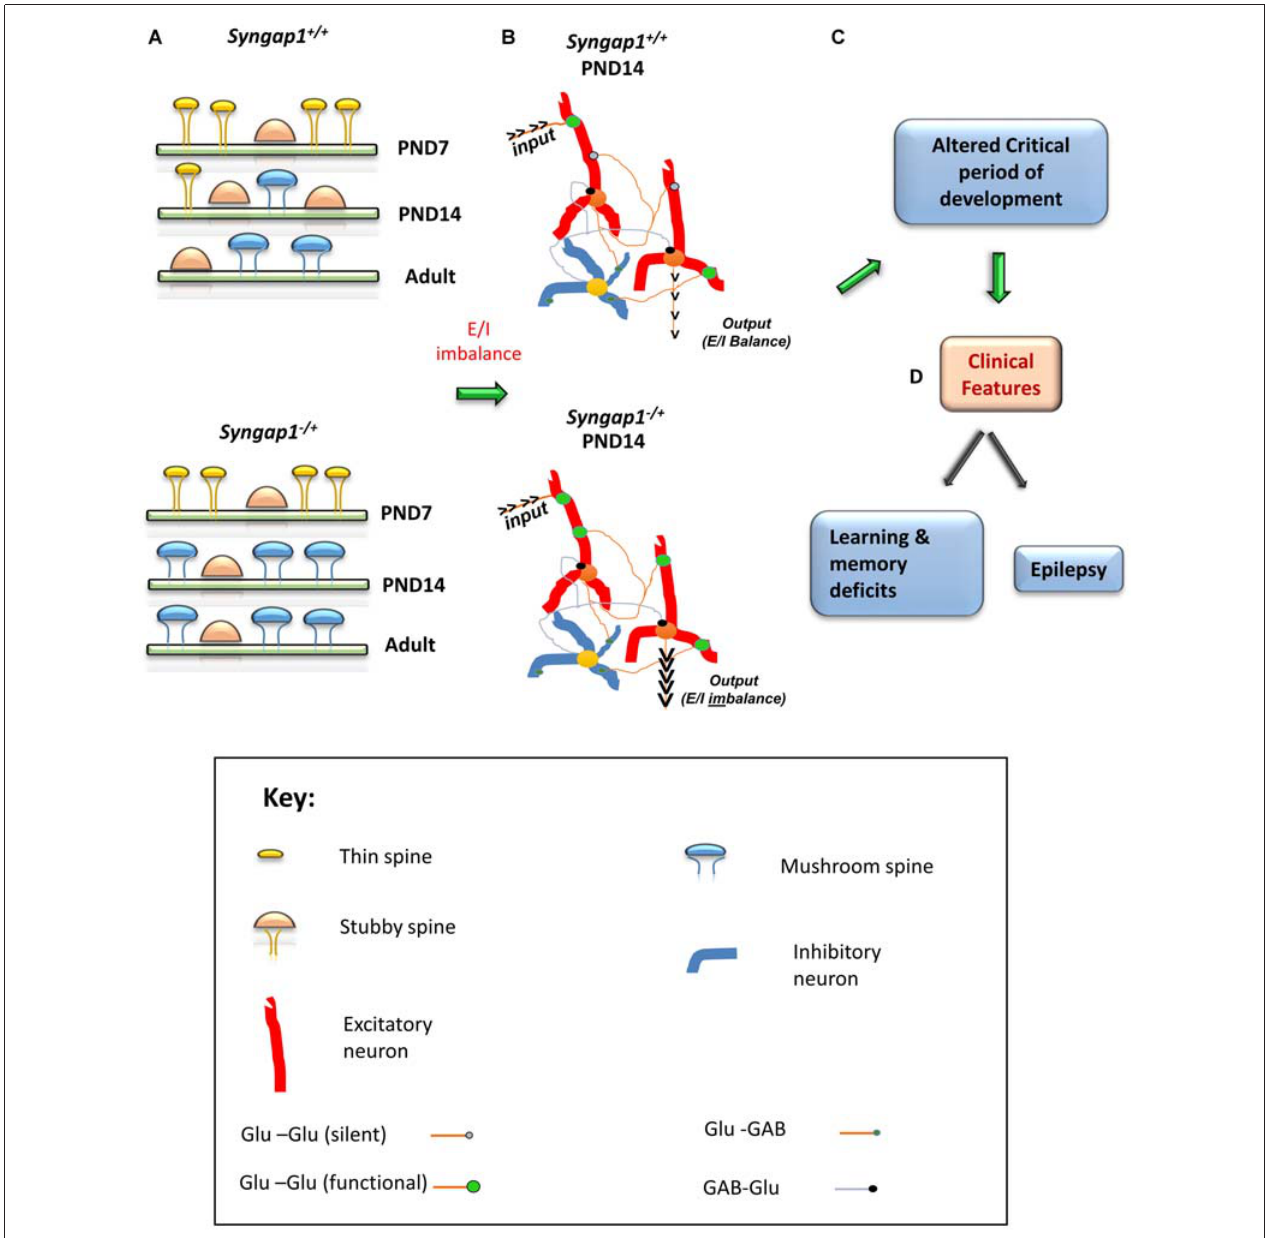
FIGURE 4 | Schematic model of the impact of Syngap1 haploinsufficiency on neuronal circuit function . This figure illustrates the impact of Syngap1 heterozygous mutation on dendritic spine morphology, neuronal connection organization, and behavioral phenotypes. Heterozygous mutations in Syngap1 lead to prematuration of dendritic spine morphology during early stages of development (A) . This causes abnormal formation and elimination of spines that leads to altered spine density and excitatory neuronal connections during development in the cortex (Aceti et al., 2015). Further, the abnormal cortical excitatory neuronal connections lead to E/I imbalance during early stages of development, which persists, into adult stages in Syngap1 Hets (B) . Consequently, these abnormalities bring about altered duration of critical period of development (C) , which leads to cognitive and social dysfunction (D) . PND, Post-natal Day. The gene products implicated in intellectual disability (ID) and/or autism spectrum disorder (ASD) are marked in Red color text. Some features are modified with permission based on Clement et al. (2012).